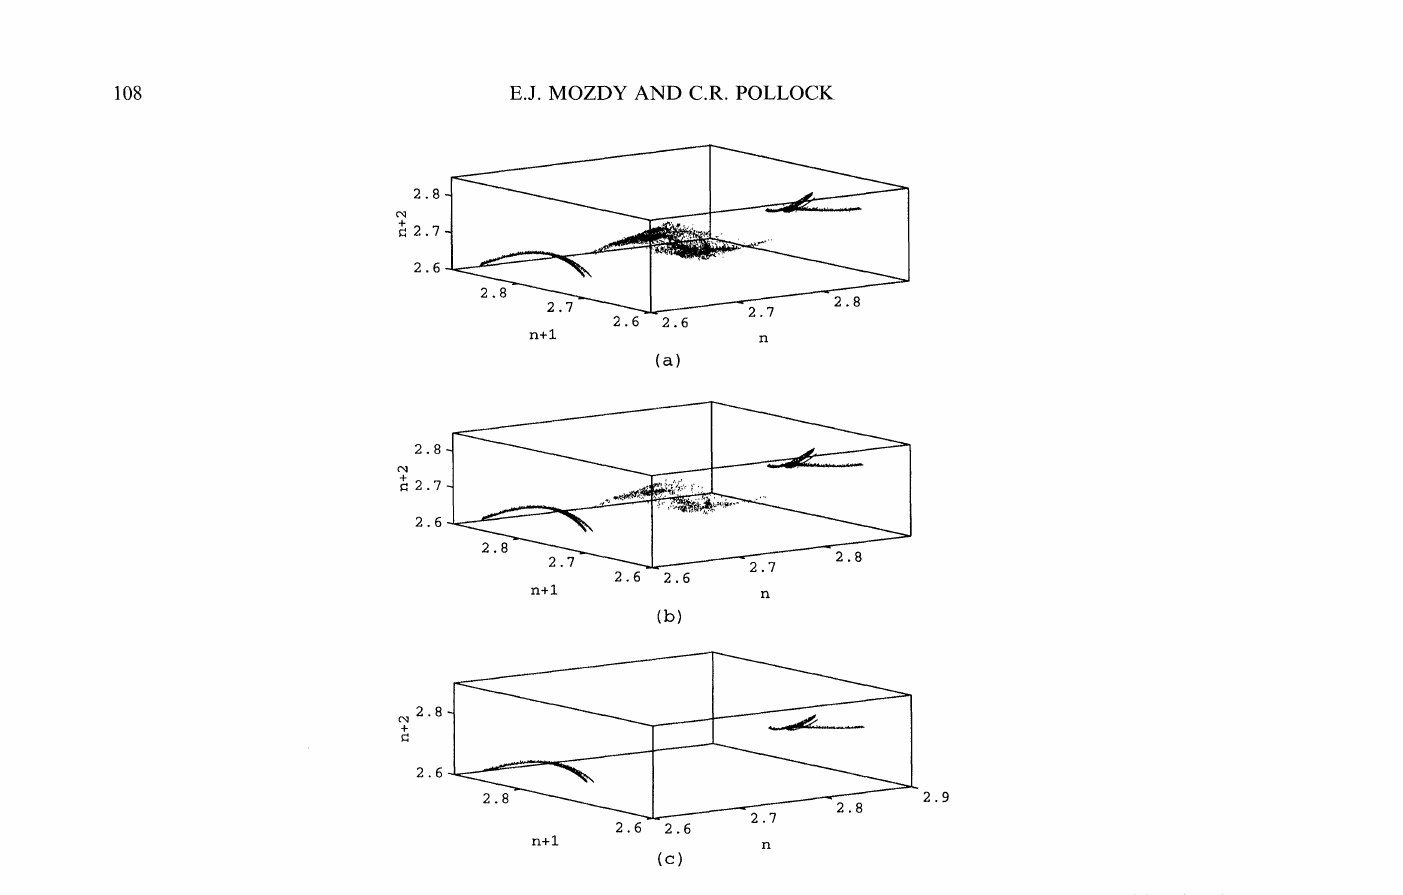
FIGURE 13 Chaotic transient in the APM output near l-- 16.72cm: (a) shows iterations 1-12000 with both an initial chaotic transient and two drastically different coexisting stable chaotic attractors; (b) shows 4001-12000 where a portion of the initial chaotic transient has passed; and (c) shows 8001-12000 where the system has settled onto the two stable coexisting chaotic